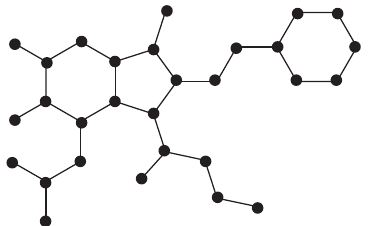
Figure 5: Molecular graph of